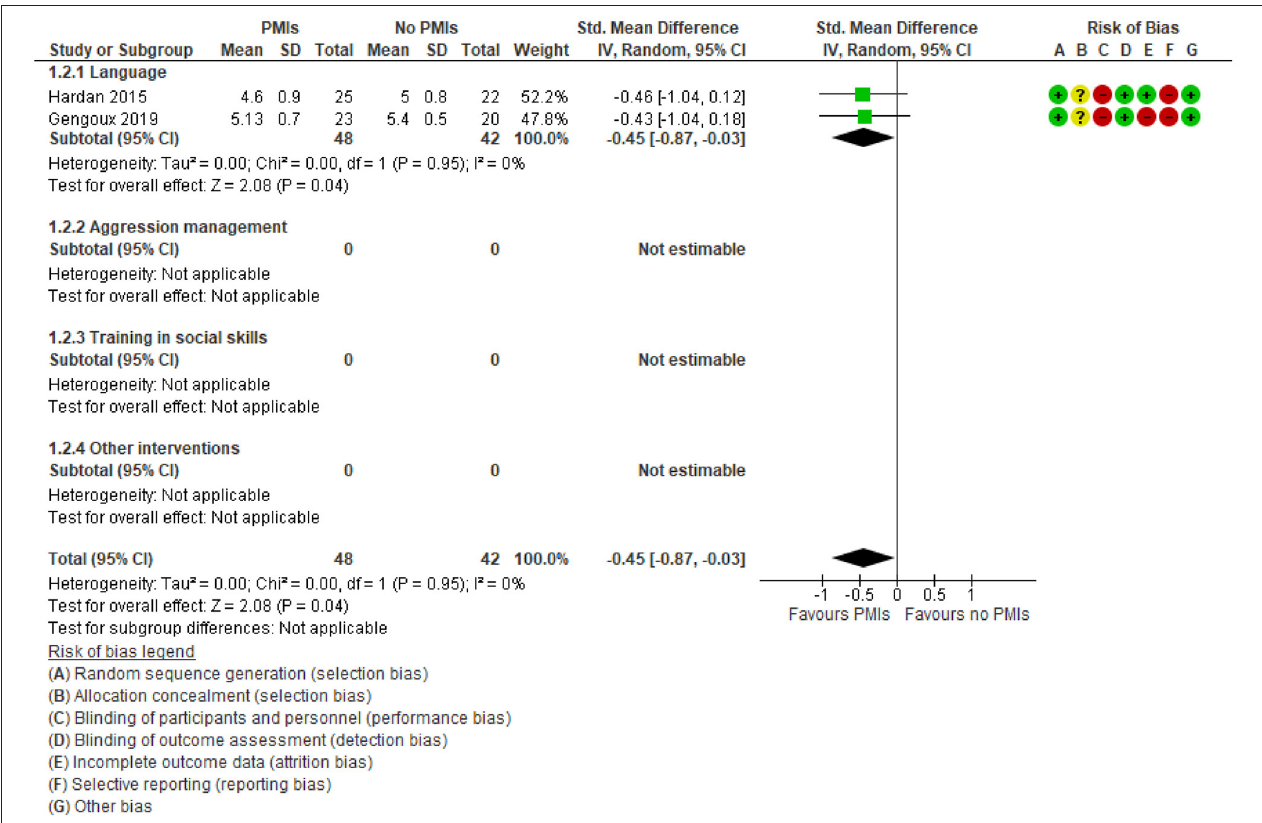
FIGURE 5 | Forest plot of comparison: PMI vs. no PMI, outcome: adaptive functioning, clinician-rated, (CGI severity), lower is better.